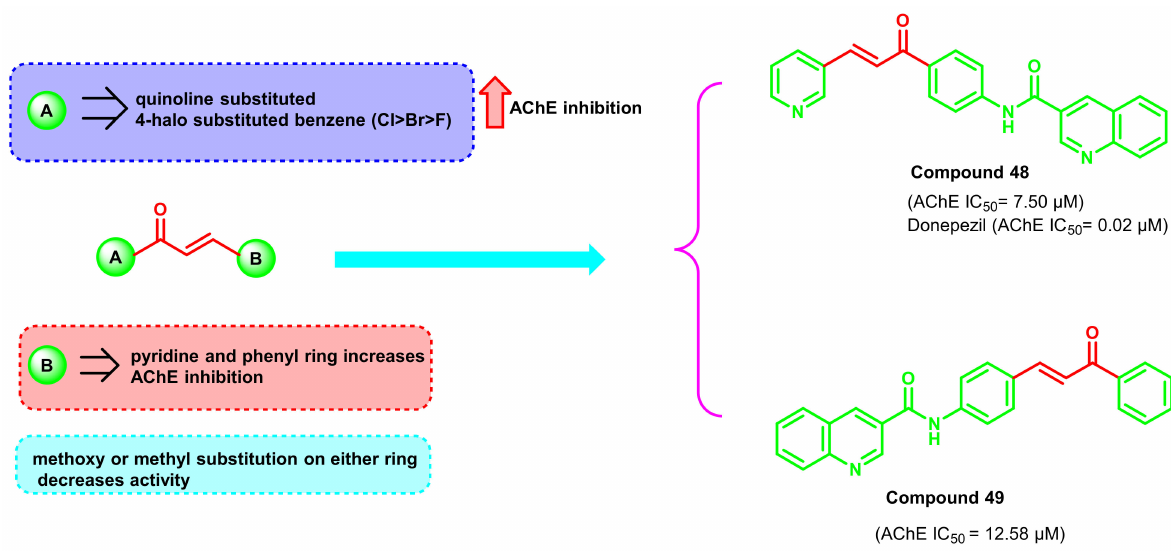
Figure 42. Chemical structures of quinolone-substituted chalcone